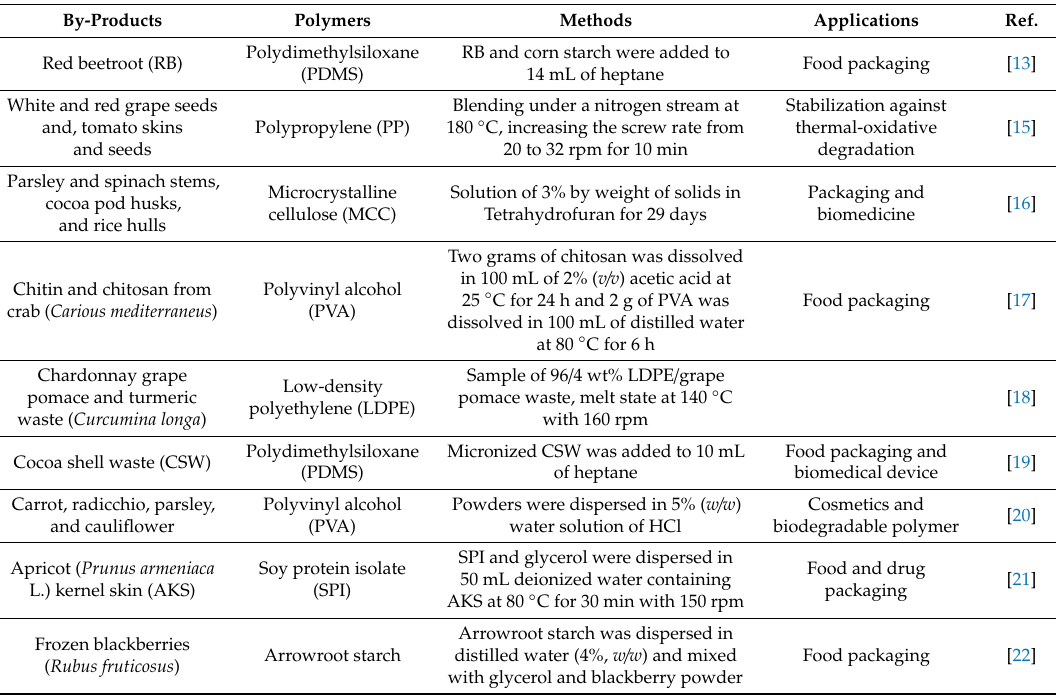
Table 1. Summary of food processing by-products-based film-type functional materials: an overview of methods and emerging